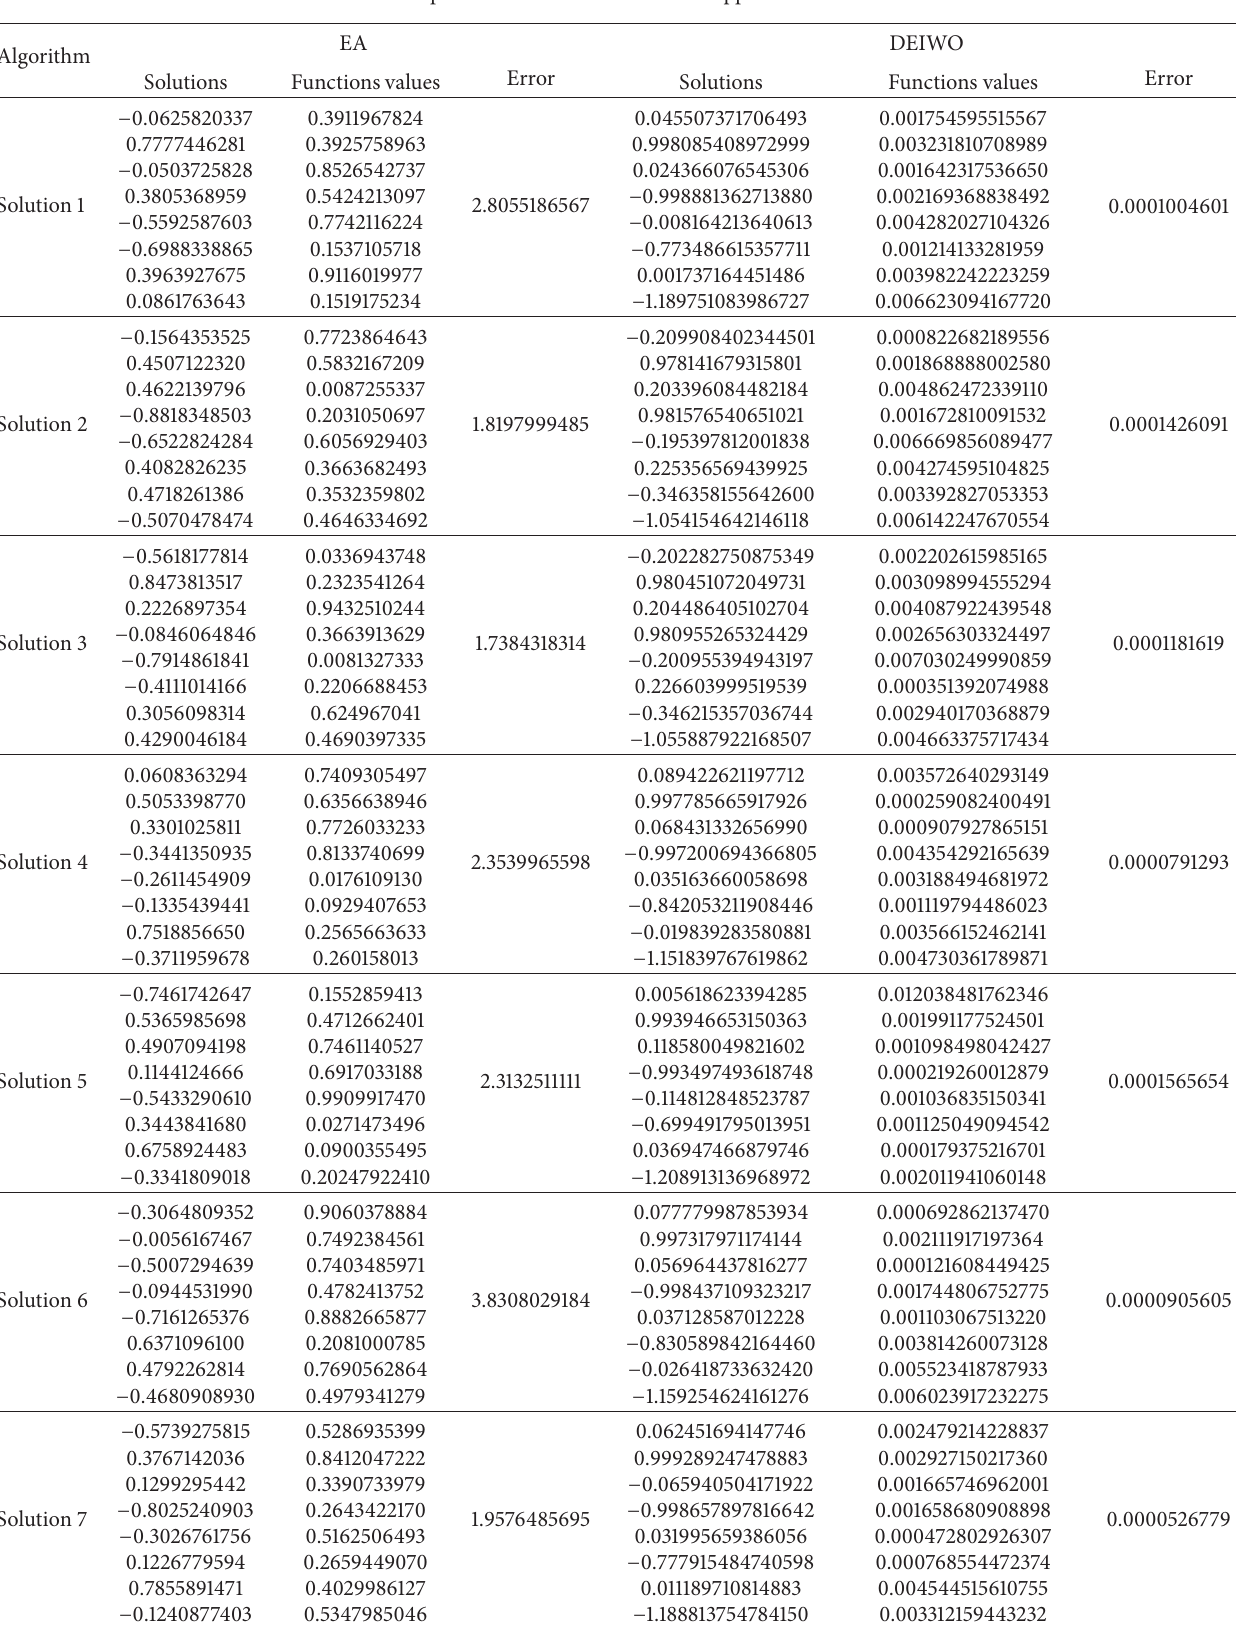
Table 9: Comparison of results for kinematic application